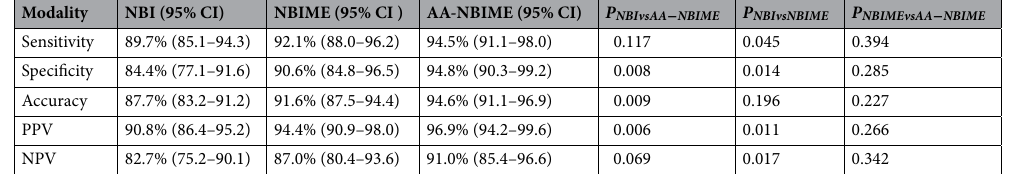
Table 3. Diagnostic performance of optical diagnosis of colorectal neoplastic polyps by three modalities for the expert group. PPV positive predictive value, NPV negative predictive value.